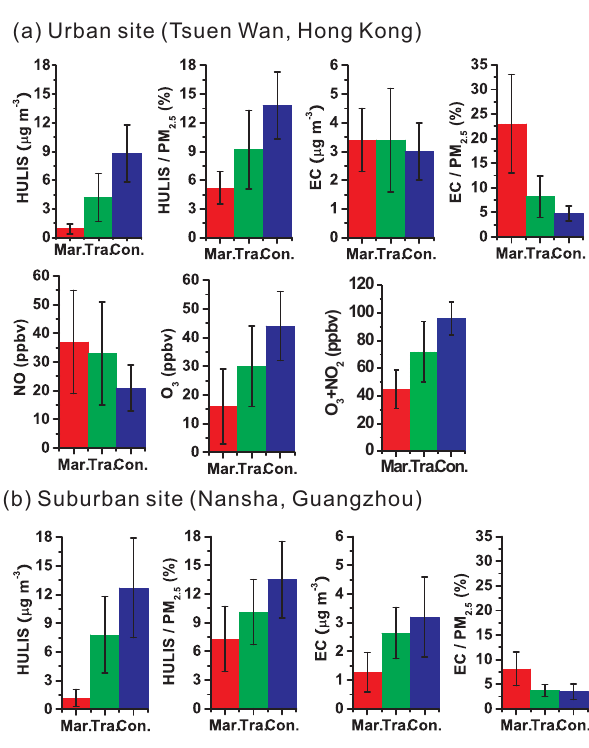
Fig. 4. Comparison of concentrations of selected particle-phase and gas-phase pollutants in three sample groups at (a) the urban site and (b) at the suburban site. The three groups are classified according to origins of the air masses influencing the sampling sites, with red, green, and blue denoting samples influenced by air masses of ma- rine, transitional, and continental origins,